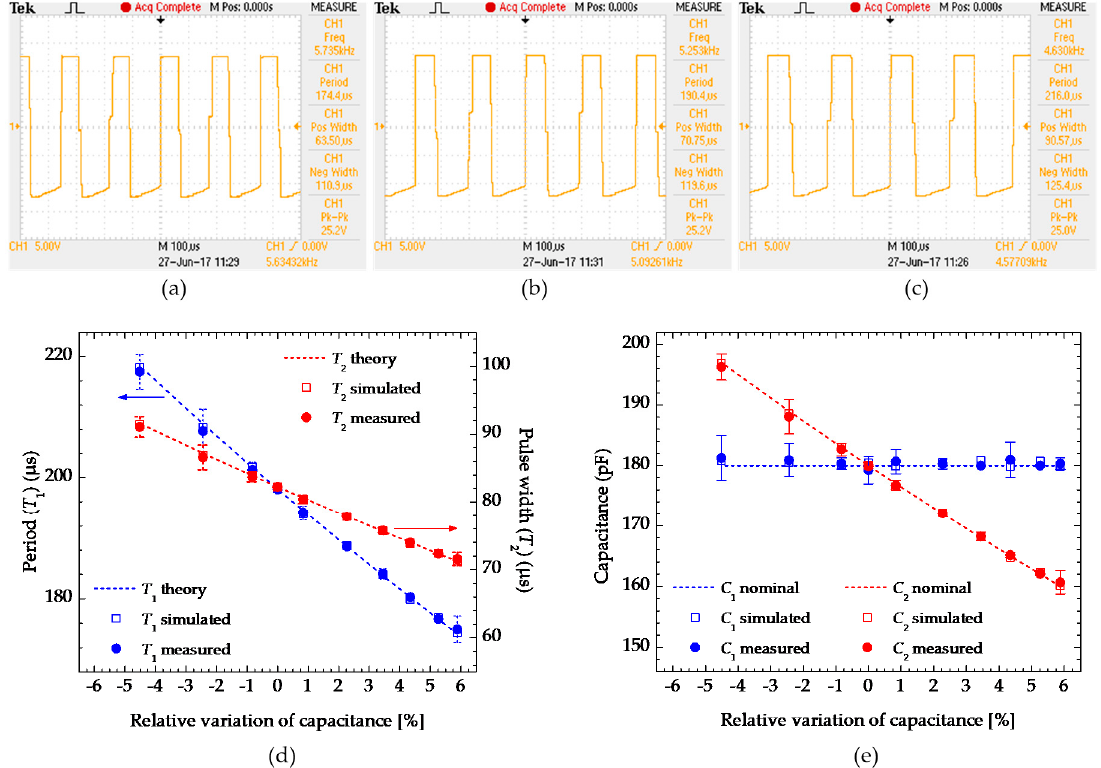
Figure 6. Oscillograms showing the output voltage signal V MIX that demonstrates the proper performances of the circuit for a configuration employing a fixed C 1 = 180 pF and ( a ) C 2 = 160 pF, ( b ) C 2 = 180 pF, and ( c ) C 2 = 197 pF; ( d ) measured, simulated, and theoretical oscillation periods T 1 and pulse widths T 2 as a function of the relative differential capacitance variation; ( e ) calculated/estimated capacitance values.